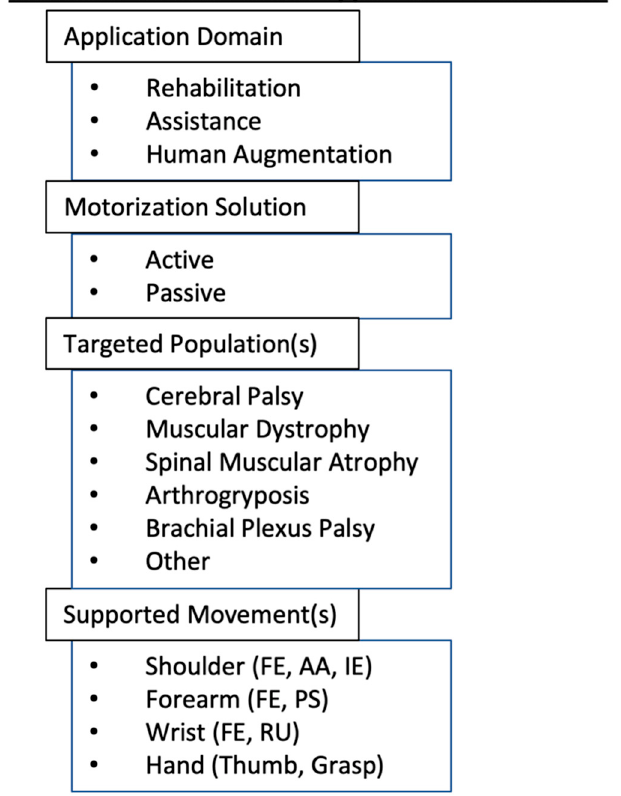
Figure 2. Categorization of sensorless and sensor-based upper limb exoskeletons in pediatrics. Abbreviations: FE: flexion – extension, AA: abduction – adduction, IE: internal – external rotation,